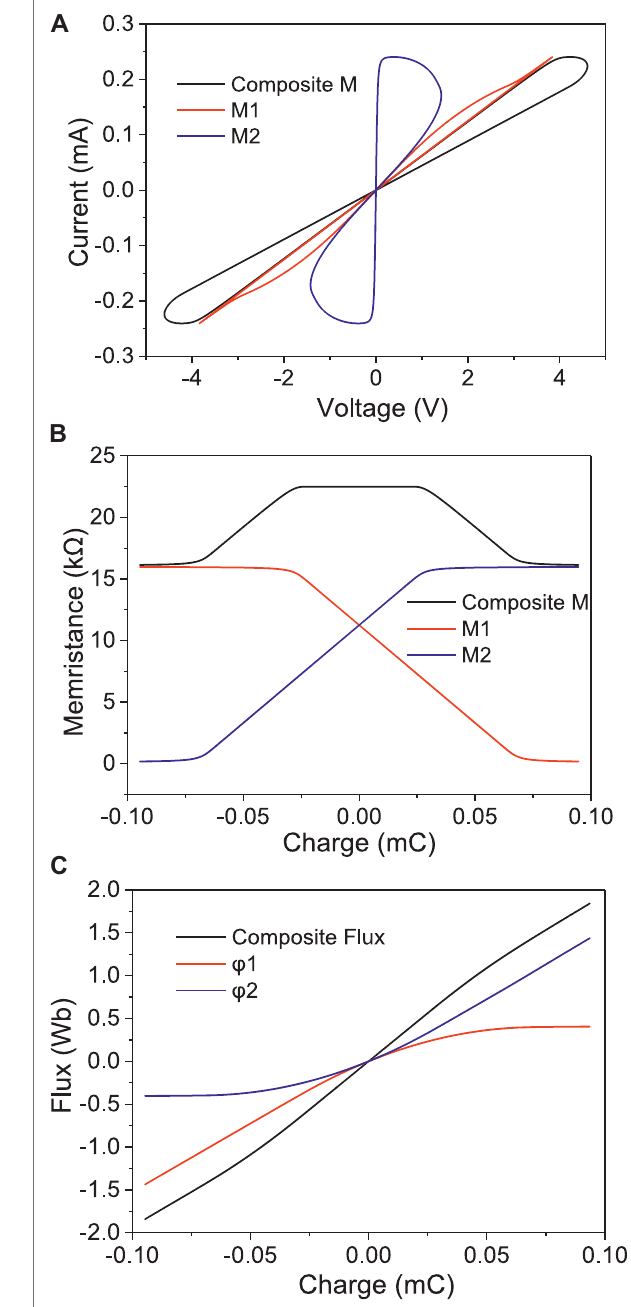
FIGURE11|(A) Current versusvoltage curves, (B) memristance versus charge curves, and (C) fl ux versus charge curves of the single memristor and twomemristors in series with same